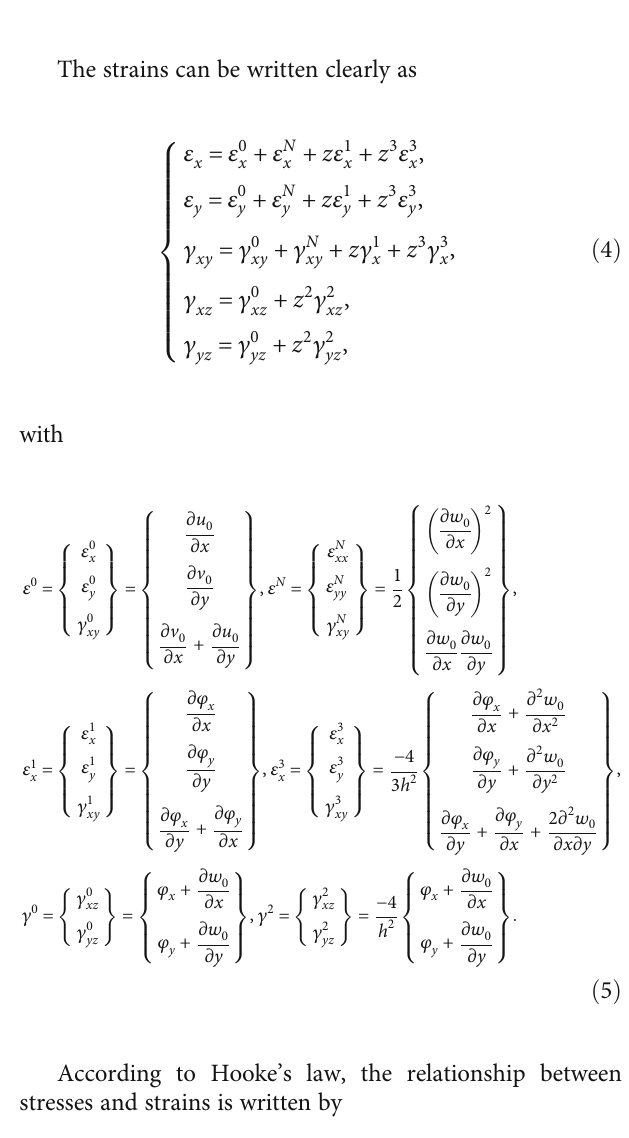
Figure 1: Schematic of a 2D-FGM